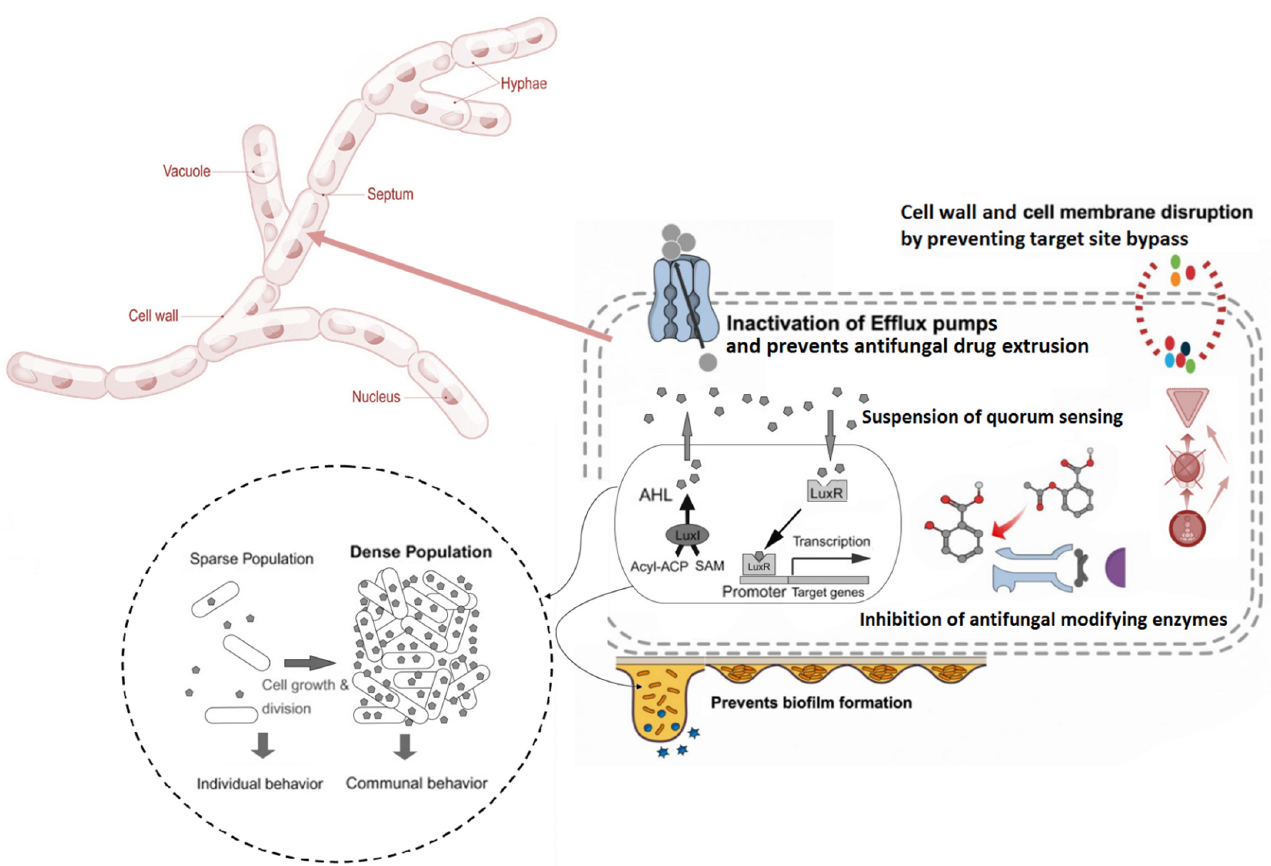
Figure 2. Antifungal action mechanisms of plant-derived essential oils.